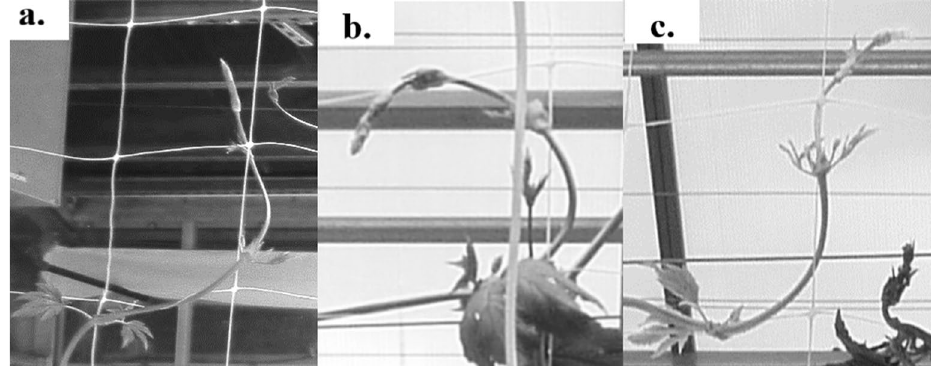
Figure 2. The 24 h sequence of forming a 90° bend in the bine between the second and third visible node from the apical meristem ( a ) first the apical meristem is bent at approximately 90°, ( b ) secondly it is undisturbed for 24 h of growth, and ( c ) thirdly the second and third visible node from the apical meristem is artificially bent at 90° and repositioned clockwise around the netting so that it can proceed to grow up the 15.25 cm rise then run of netting (e.g. a 15.25 cm × 15.25 cm rise and run is sequentially bent into the shape of a bine staircase at an average slope of 45°). Note, images are black and white for color consistency to not distract the reader by the color variations brought about by the red and blue LED illumination under daytime versus nighttime